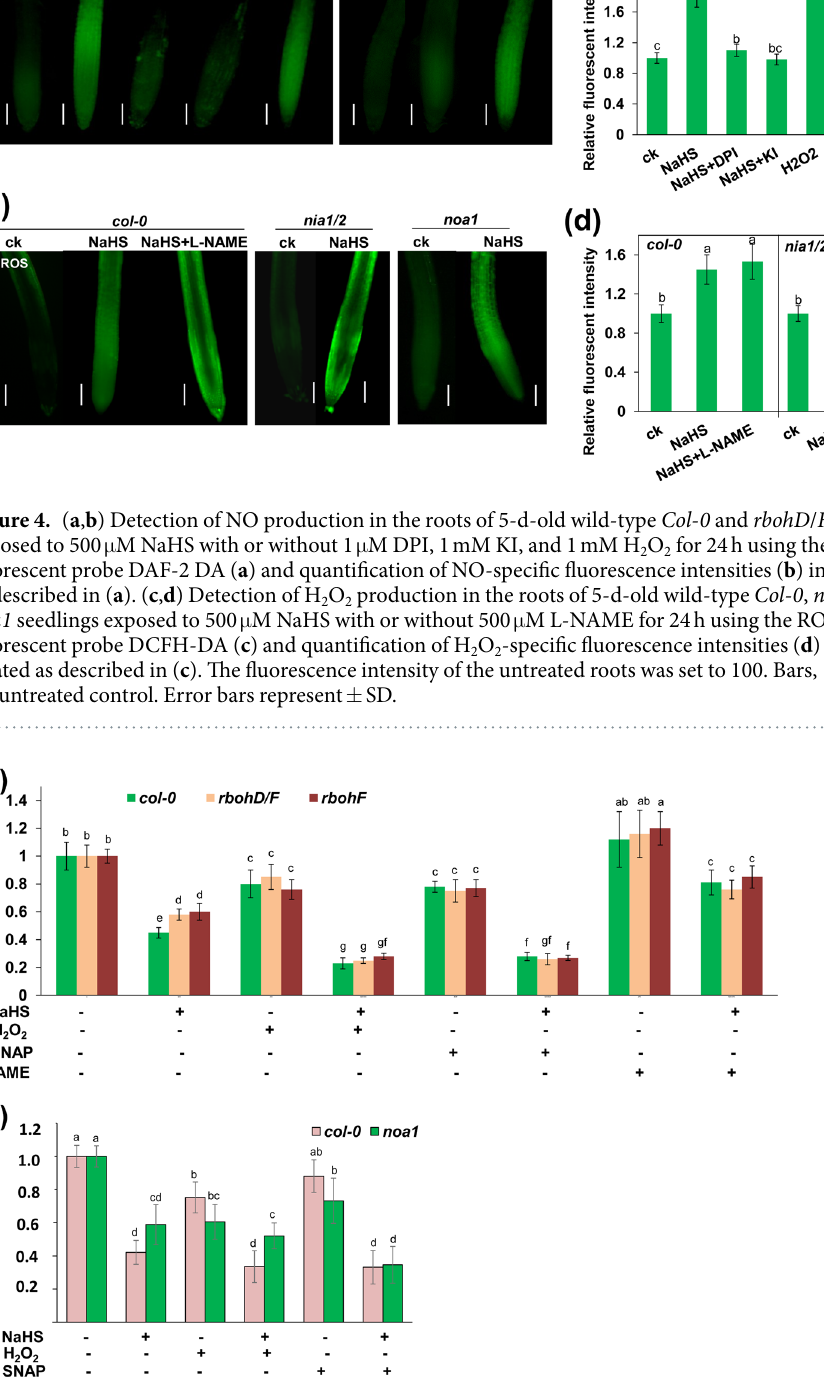
Figure 5. ( a ) Relative root growth of Col - 0 , rbohF , and rbohD / F seedlings exposed to 500 μ M NaHS with or without 1 mM H 2 O 2 , 100 μ M SNAP, and 500 μ M L-NAME for 2 d compared with untreated seedlings. ( b ) Relative root growth of Col - 0 and noa1 seedlings exposed to 500 μ M NaHS with or without 1 mM H 2 O 2 and 100 μ M SNAP for 2 d compared with untreated seedlings. n = 45. Error bars represent ± SD. Different letters indicate significantly different values (P < 0.05 by Tukey’s